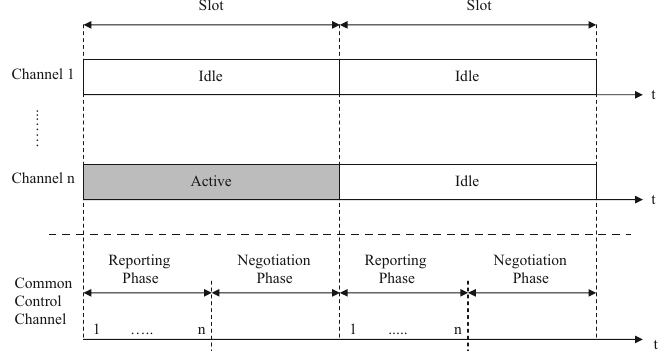
Figure 9. Opportunistic MAC